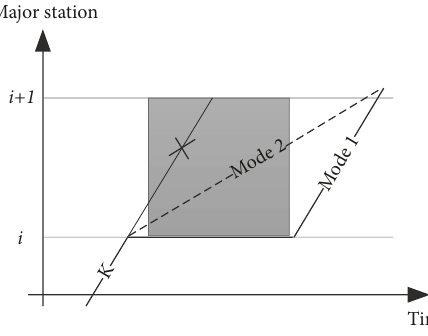
Figure 5: An illustration of constraint